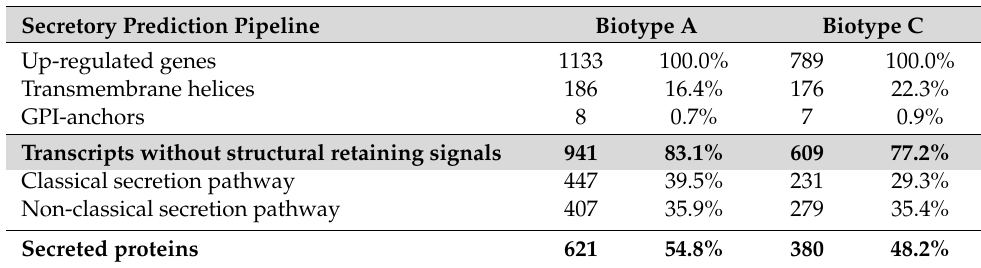
Table 1. Combined secretory prediction pipeline. The table illustrates the steps applied to predict secreted proteins among the DEGs of root-galling grape phylloxera larvae of biotype A and biotype C. The online tools TMHMM, PredGPI, SignalP, and SecretomeP were used in a stepwise fashion to determine the likelihood of proteins being secreted